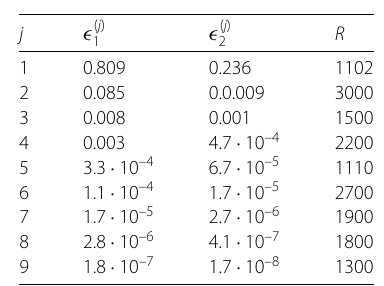
Table 2 (cid:15) ( j ) , (cid:15) ( j ) , j = 1, ... , N and the respective Rayleigh number R in which the maximum takes place 1 2 for different dimensions j of the reduced basis space. R is in the interval [1102;3000] for solutions S 1